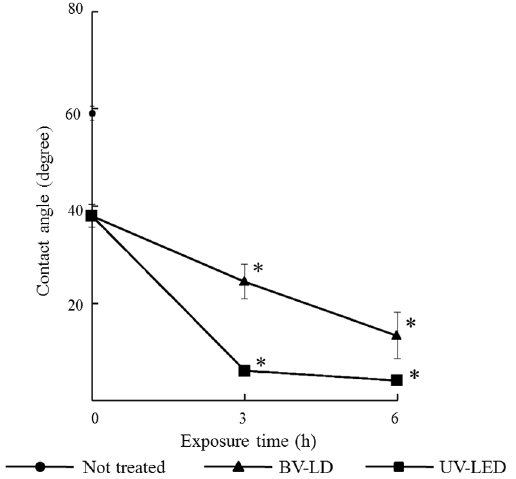
Figure 4. Changes in the contact angle of each specimen after titania treatment.